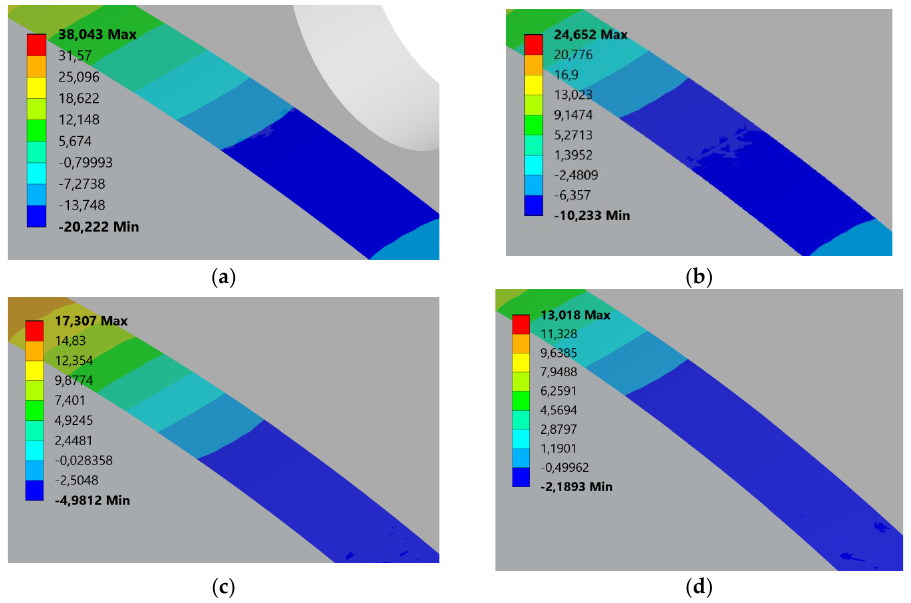
Figure 20. Normal stress results for hybrid gears with α d = 30° for different RTs; ( a ) 0.5 xm, ( b ) 1 xm, ( c ) 1.5 xm, ( d ) 2 xm .